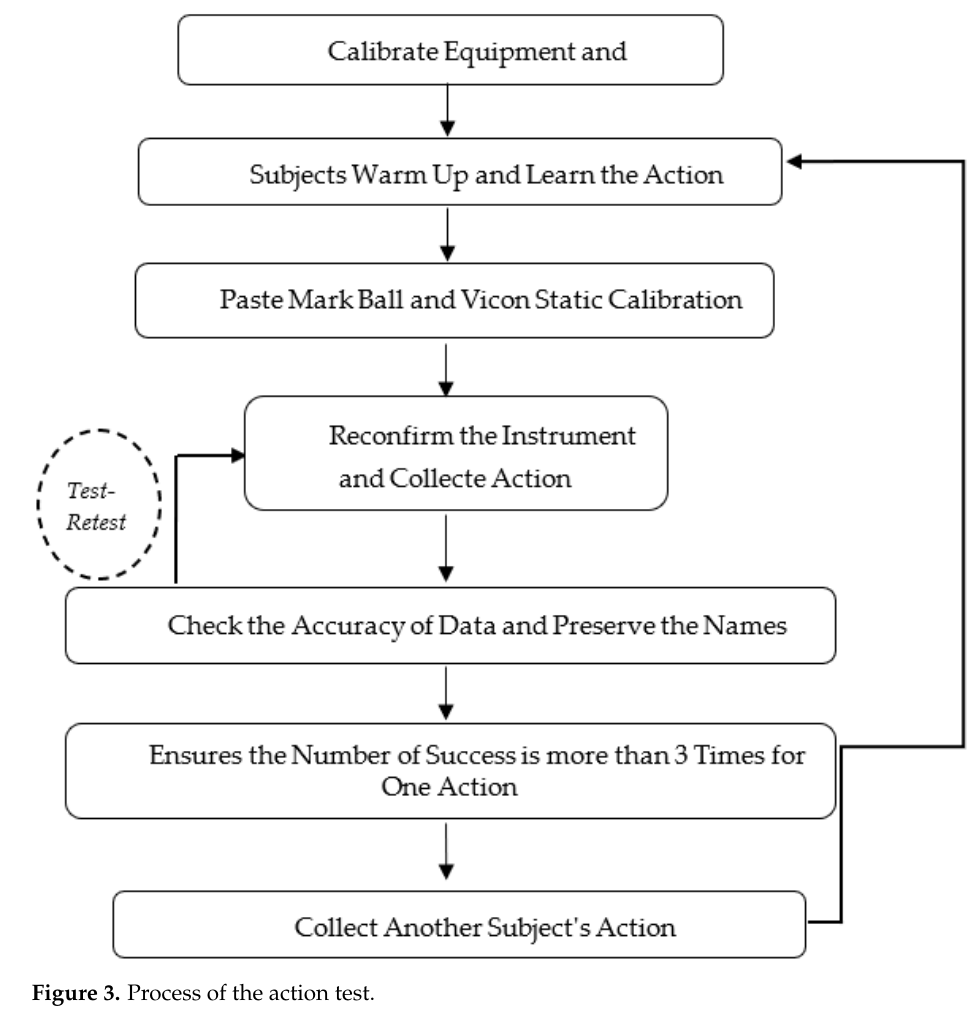
Figure 3. Process of the action test.